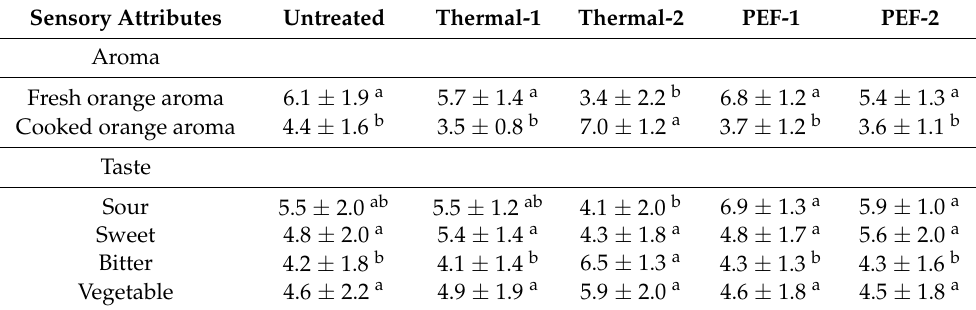
Table 3. Effect of PEF and thermal treatments on sensorial properties of squeezed orange juice Sensory Attributes Untreated Thermal-1 Thermal-2 PEF-1 PEF-2 Aroma Fresh orange